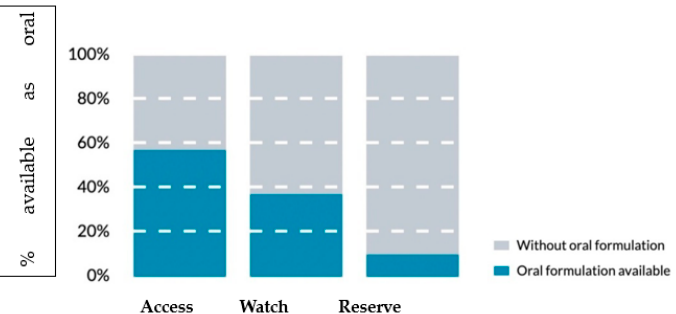
Figure 1. Percentage of oral formulations by AWaRe category (modi fi ed by [43]).